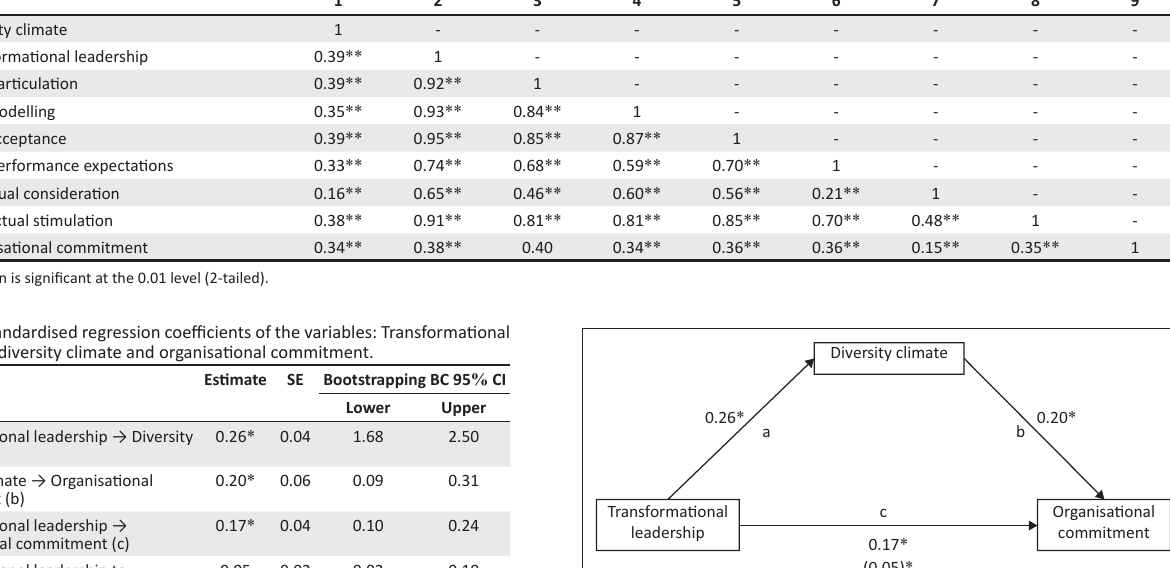
TABLE 3: Correlation analysis, diversity climate, transformational leadership and organisational commitment.